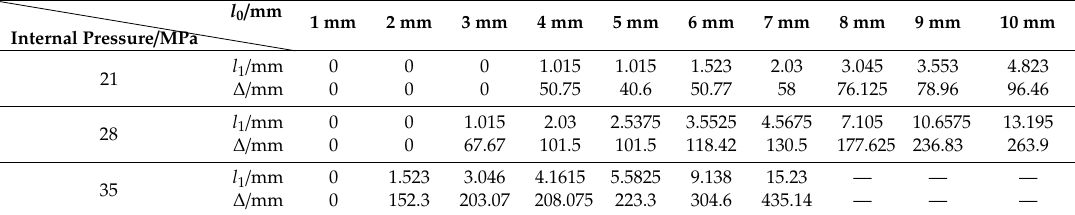
Δ Table 5. Crack propagation rates and half-crack propagation length l 1 for different initial crack length l 0 and internal pressures. Table 5. Crack propagation rates ∆ and half-crack propagation length l 1 for di ff erent initial crack length l 0 and internal pressures.